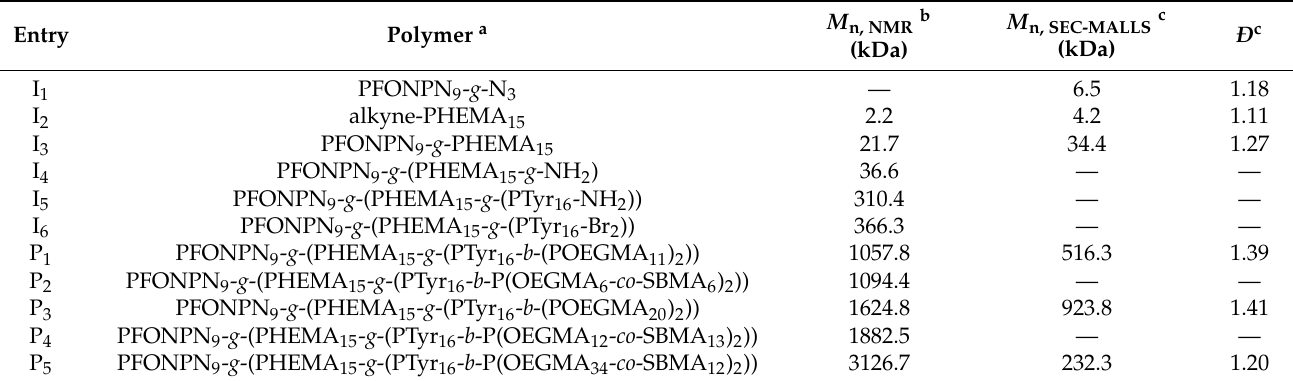
Table 1. MW, Ð , and DP of all the synthesized